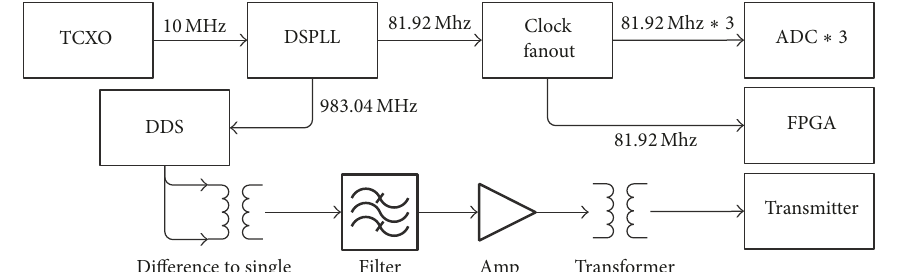
Figure 4: Clock and signal generator module.